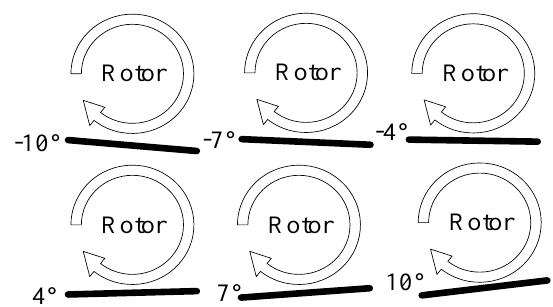
Figure 13. Photo of the field validation test.